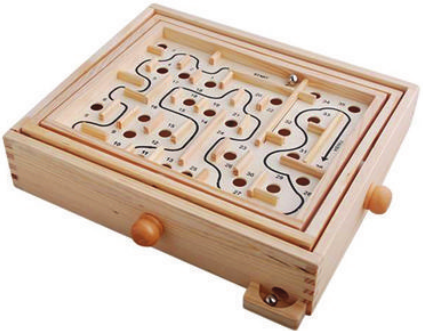
Figure 2: A photo of a classic Labyrinth , which was the